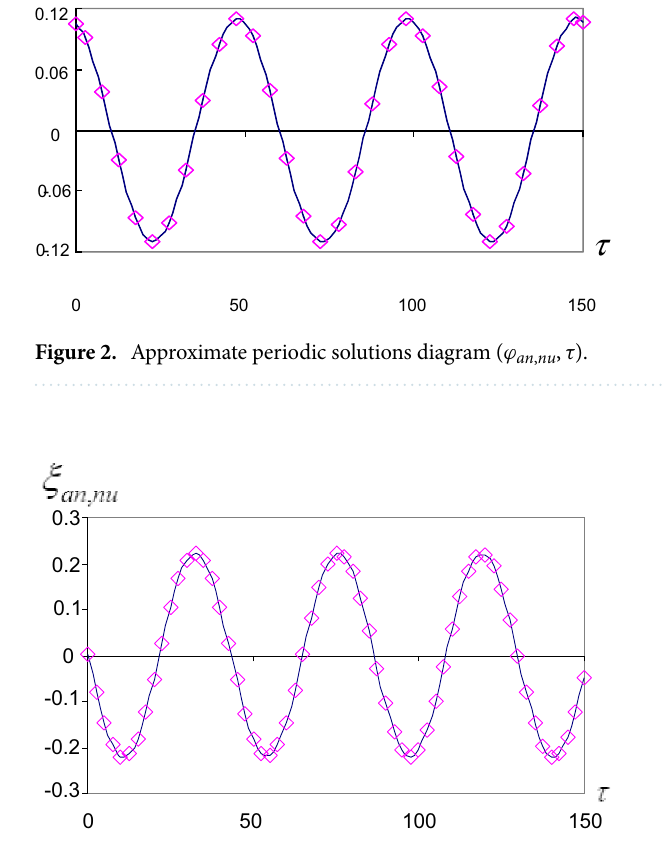
Figure 3. Approximate periodic solution diagram ( ξ an , nu , τ ).